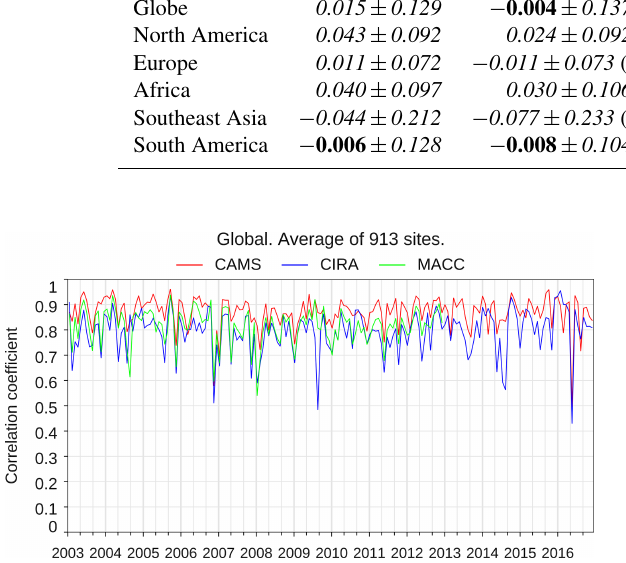
Figure 23. Time series of global correlation coefficient with AERONET AOD from the three reanalyses. CAMSRA is shown in red, CIRA in blue and MACCRA in